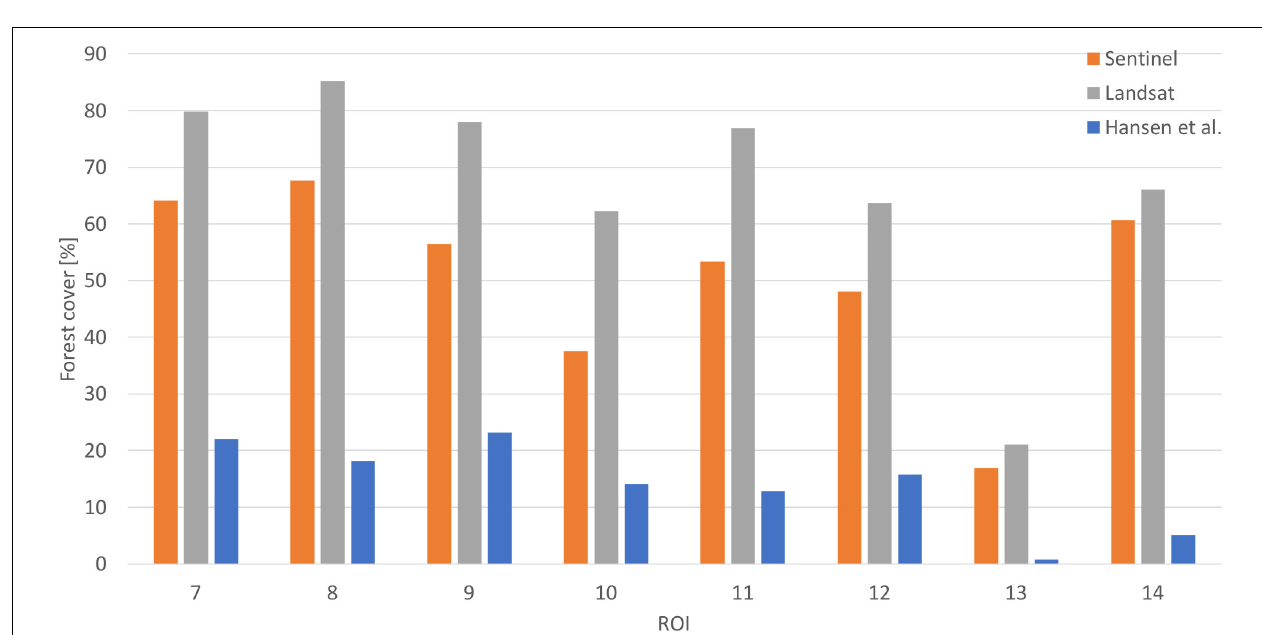
FIGURE 9 | Precipitation scenario including cloud forest fog harvesting for representative years (low, medium, and high). The background color depicts annual monsoon precipitation (PCF) for a medium year in [mm] and the bar graphs show annual monsoon precipitation (PCF) in [m3] for low, medium and high monsoon years. The pie charts show forest and non-forest land cover per ROI. All data are based on the period from 1992 to 2017.